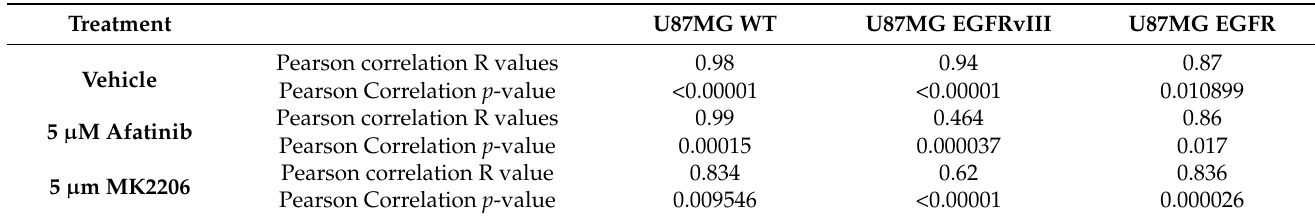
Figure 6. Immunostaining of AR S210/213 and AKT S473 in U87MG subclones. ( A ) U87MG WT, U87MG EGFR, and U87MG EGFRvIII cells were treated with vehicle (1% DMSO), 5 μM afatinib, or 5 μM MK2206 for 6 h and analyzed by immunofluorescence with antibodies against pAR (S210/213) (red) and pAKT (S473) (green). ( B , C ) AR nuclear localization was determined by quantifying the relative fluorescent intensity ratio between nuclear and cytosolic compartments using ImageJ software. The results are expressed as mean ± SD following normalization to U87MG WT ( B ) or the vehicle-treated subclones ( C ); p -values between the groups are indicated. Table 2. Correlation analysis of the colocalization of AR S210/213 with AKT S473 in the U87MG subclones.